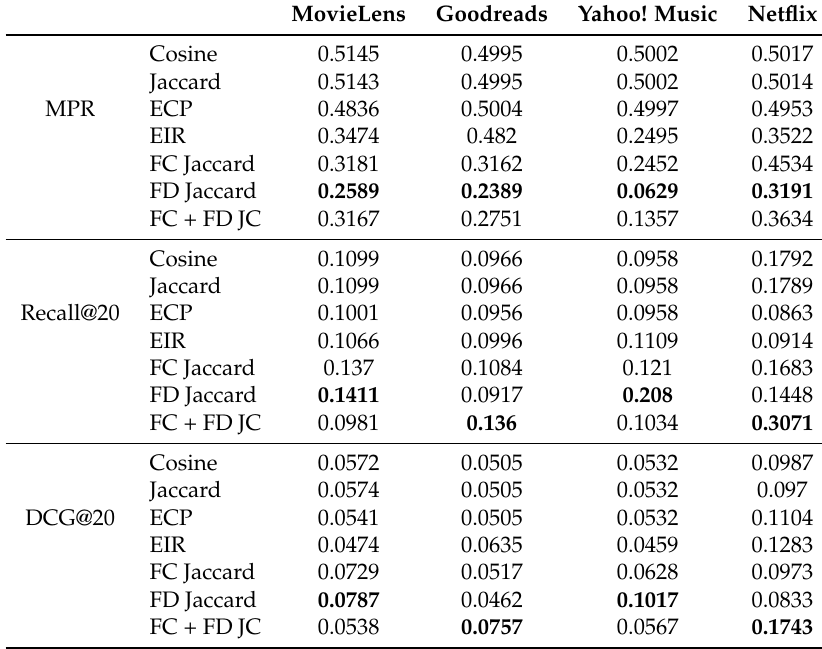
Table 10. Experiments over the first two quantiles (based on KDE estimations of 50%). Best performing methods are indicated in